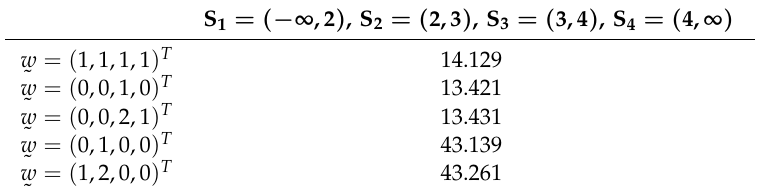
Table 7. CWKL divergence between π 1 and π 2 .